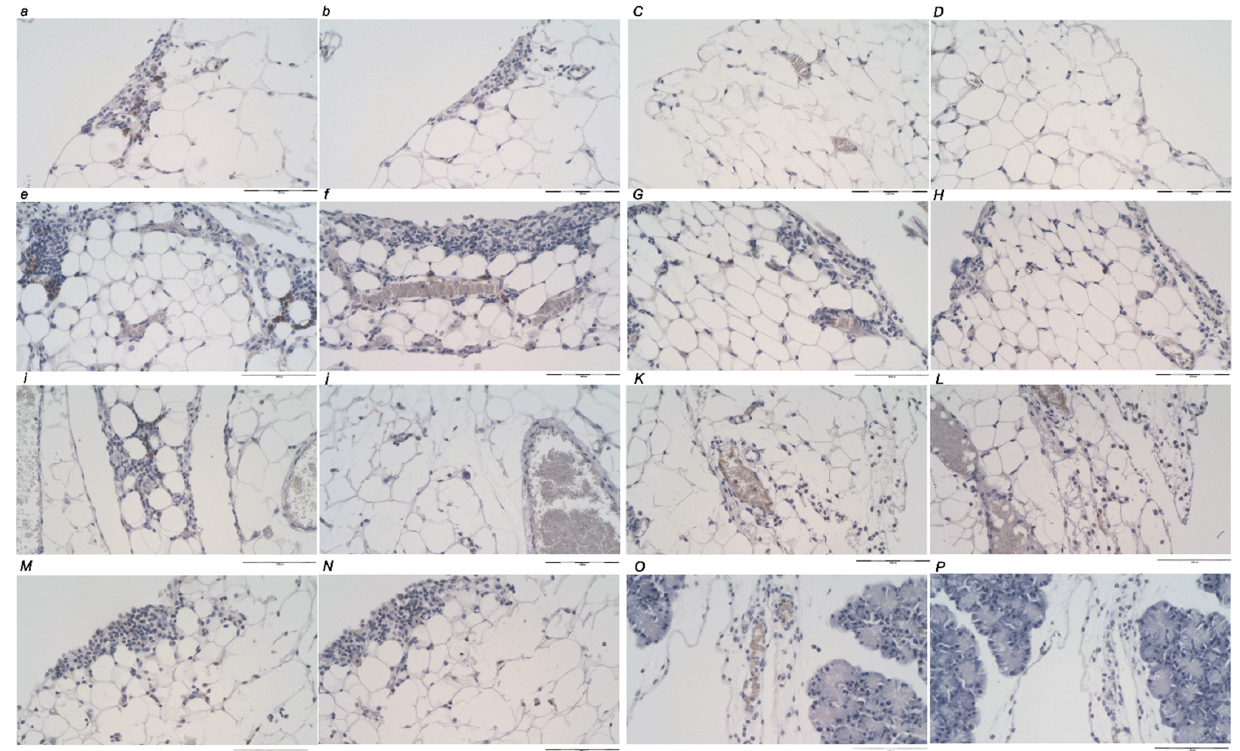
Figure 18. CD68- (PG-M1) and CD163-positive cells’ illustrative immunochemistry in rats with obstructed bile duct ( a – P ) at the end of the ligation time periods of 30 min, 5 h, and 24 h; as an early regimen at 0–30 min ( a – D ), 0–5 h ( e – H ), and 0–24 h ( i – L ) application sacrifice period; and as delayed regimen at 4.30 h–5 h ( M , N ) and 5 h–24 h ( O , P ) application sacrifice period in controls ( a , b , e , f , i , j ) and BPC 157-treated rats ( C , D , G , H , K – P ). “Hot spots” at 200× magnification. ( a , b ) (control, 0–30 min). Considerable number of positive CD68 (PG-M1)-positive macrophages, but no CD163- positive macrophages in the peripancreatic fat tissue. ( C , D ) (BPC 157, 0–30 min). No CD68- (PG-M1) and CD163-positive macrophages. ( e , f ) (control, 0–5 h). Considerable number of positive CD68- (PG-